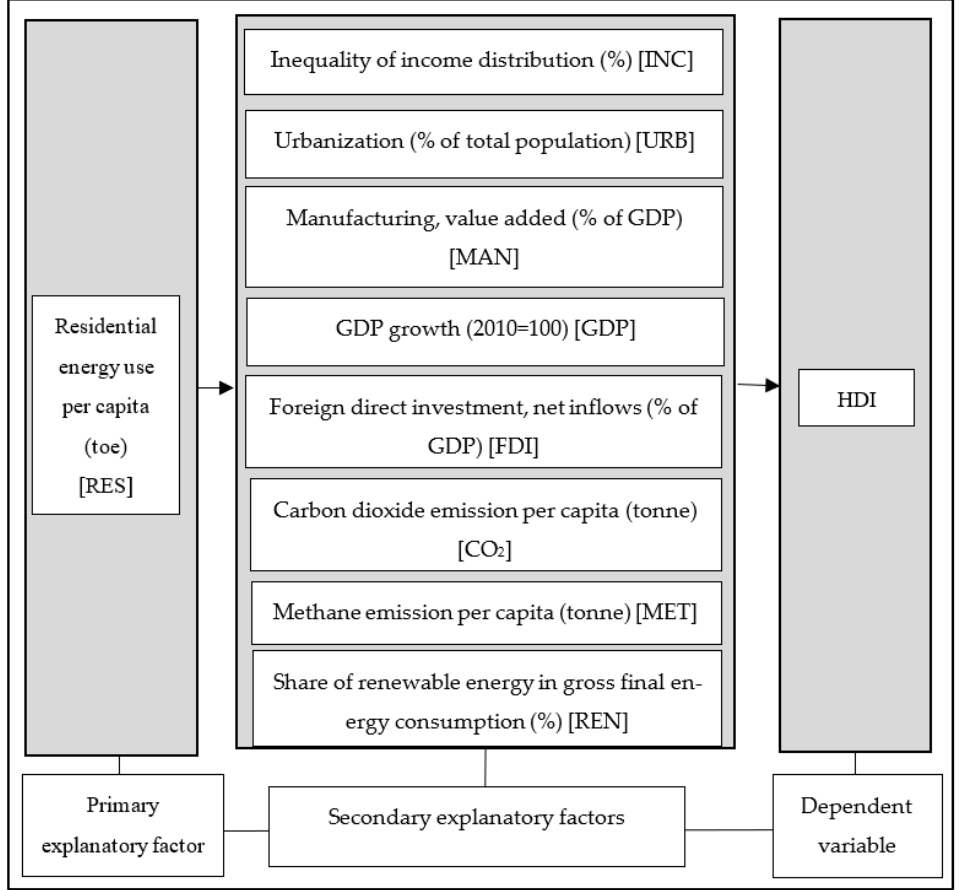
Figure 2. Causality relations of the groups of explanatory variables. Table 2. Regression results.